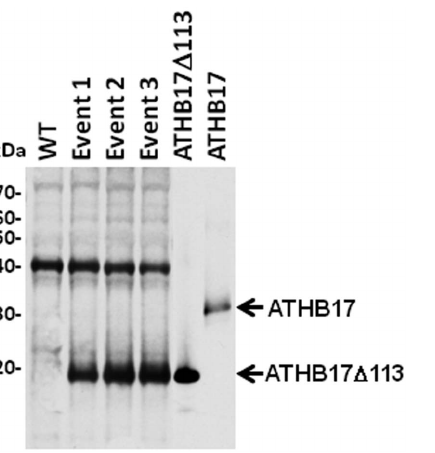
Figure 4. Western blot analysis showing truncated ATHB17 protein in transgenic maize events. Extracts from WT and transgenic maize events were separated on SDS-PAGE, transferred on to nitrocellulose membrane, and probed with ATHB17 antibody. An E. coli purified preparation of full-length and truncated protein was also analyzed for comparison with plant expressed protein as a control. Molecular weight markers are shown on the left.